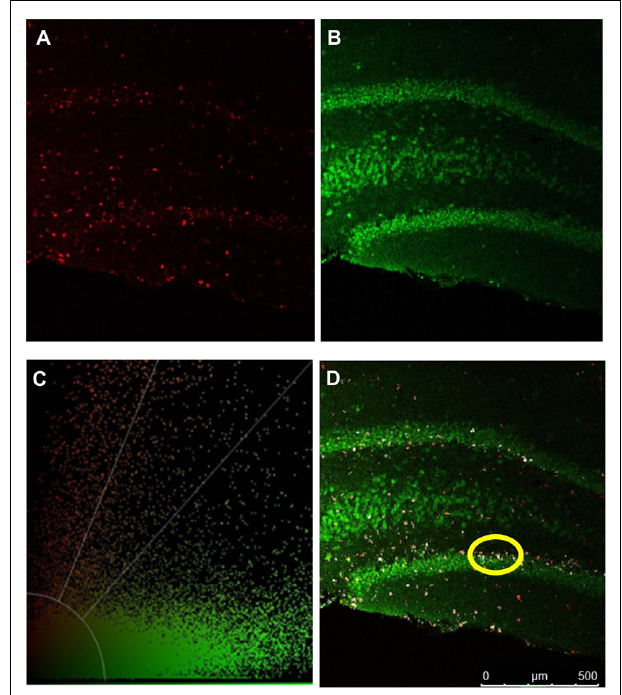
FIGURE 7 | Confocal microscopy. Confocal microscopy was used to quantify mitogenesis and neurogenesis in the hippocampal dentate